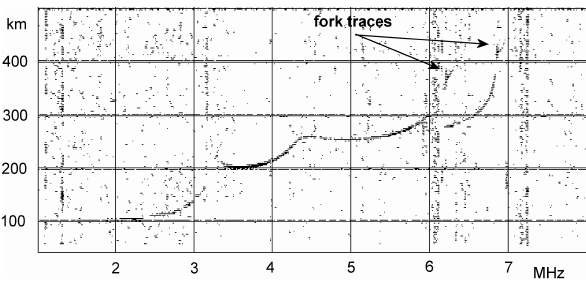
Fig. 2. Fig. 2. Ionogram recorded on 26 September 1997 at Rome at 09:00UT where fork traces, caused probably by TIDs, at critical frequencies of both the ordinary and extraordinary F2 rays are visi-